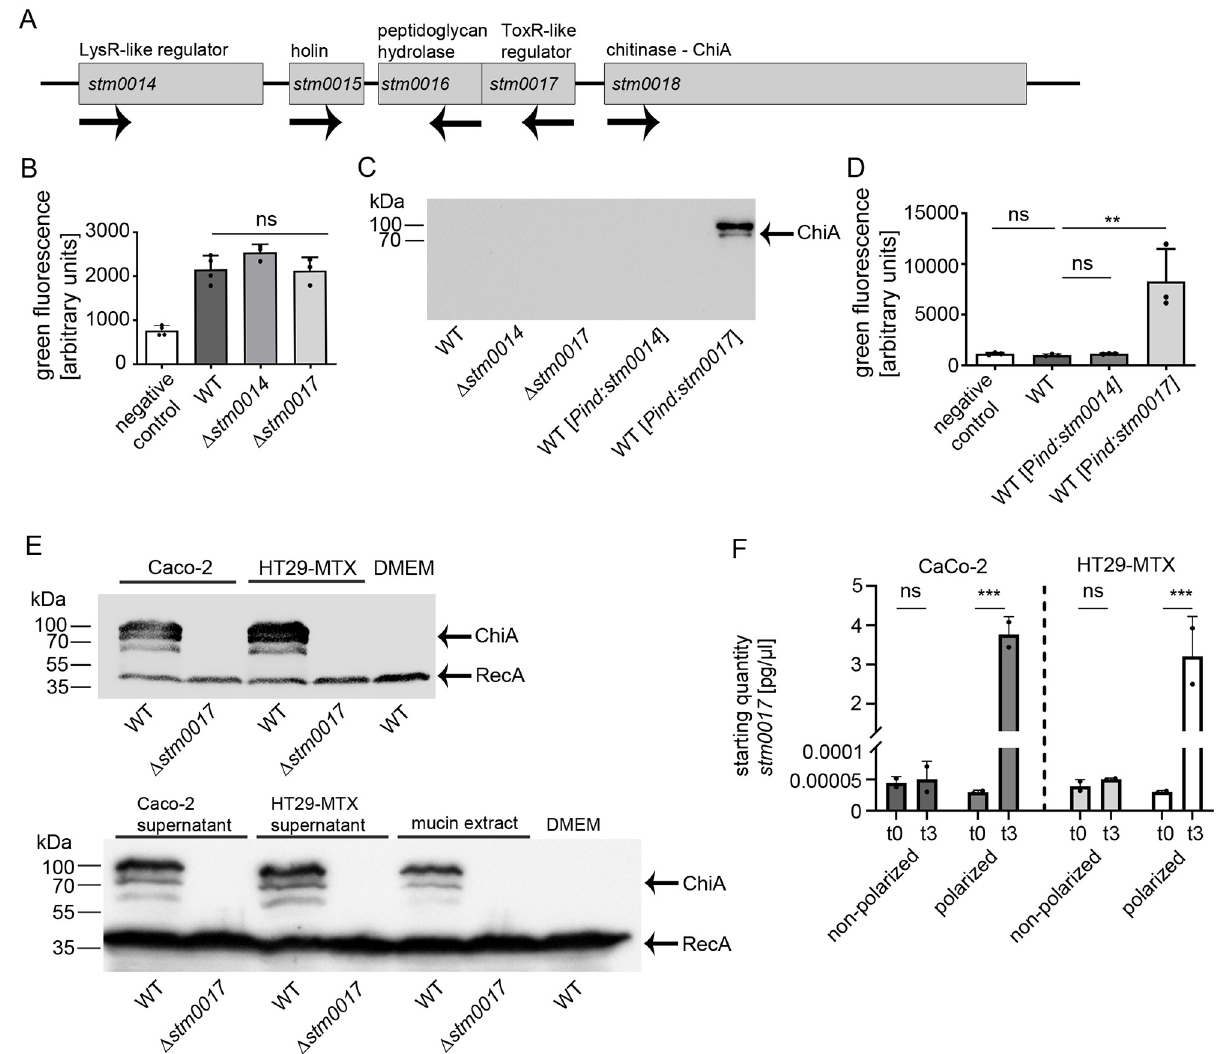
Fig 2. ChiA expression is strictly regulated by the chitinase regulator ChiR (STM0017). (A) Schematic overview of the chitinase A operon in S . Typhimurium. (B) chiA promoter activity assay of wild-type S . Typhimurium and clean deletion mutants Δ stm0014 and Δ stm0017 each carrying a plasmid expressing sfGFP under the control of the chiA promoter ( chiA-P_sfGFP ). As a negative control, S . Typhimurium wild-type carrying a promoterless_sfGFP plasmid was used. The strains were grown in standard LB rich medium for 6 h and harvested for fluorescence intensitity analyses. Statistical analysis was implemented with ordinary one-way ANOVA and Bonferroni´s multiple comparisons test P > 0.05: ns. (C) Detection of ChiA expression by Western blot analysis in S . Typhimurium wild-type, Δ stm0014 , and Δ stm0017 mutant strains, carrying chromosomally encoded 3xFLAG tagged ChiA. To overexpress stm0014 and stm0017 , genes were cloned in a rhamnose inducible plasmid pTG0034 or pTG0035 respectively. Strains were grown for 6 h in standard LB rich medium. To induce the plasmids, 0.1% rhamnose was added to the medium for 3 h. (D) chiA promoter activity assay with S. Typhimurium carrying a chromosomal replacement of chiA :: sfGFP . In this strain, plasmids pTG0034 ( stm0014 ) or pTG0035 ( stm0017 ) were introduced for overexpression analyses under LB rich medium growth conditions. Statistical analysis was implemented with ordinary one-way ANOVA and Bonferroni´s multiple comparisons test P > 0.05: ns; P � 0.05: * ; P � 0.01: ** . (E) ChiA expression analysis by Western blot. Indicated S . Typhimurium strains (wild-type and Δ stm0017 ), carrying chromosomally encoded 3xFLAG tagged ChiA and plasmid pTG0069 (RecA-3xFLAG), were incubated for 3 h with polarized Caco-2 and HT29-MTX cells, cell-free supernatants of polarized Caco-2 and HT29-MTX cells, and 1% porcine mucin extract (Sigma) and harvested for Western blot analysis. RecA was used as a loading control. (F) Quantitative RT-PCR analysis of stm0017 mRNA levels of S . Typhimurium before and after 3 h contact with polarized and non-polarized Caco-2 and HT29-MTX cells. Statistical analysis was implemented with unpaired student`s t-test P > 0.05: ns; P � 0.001: *** .